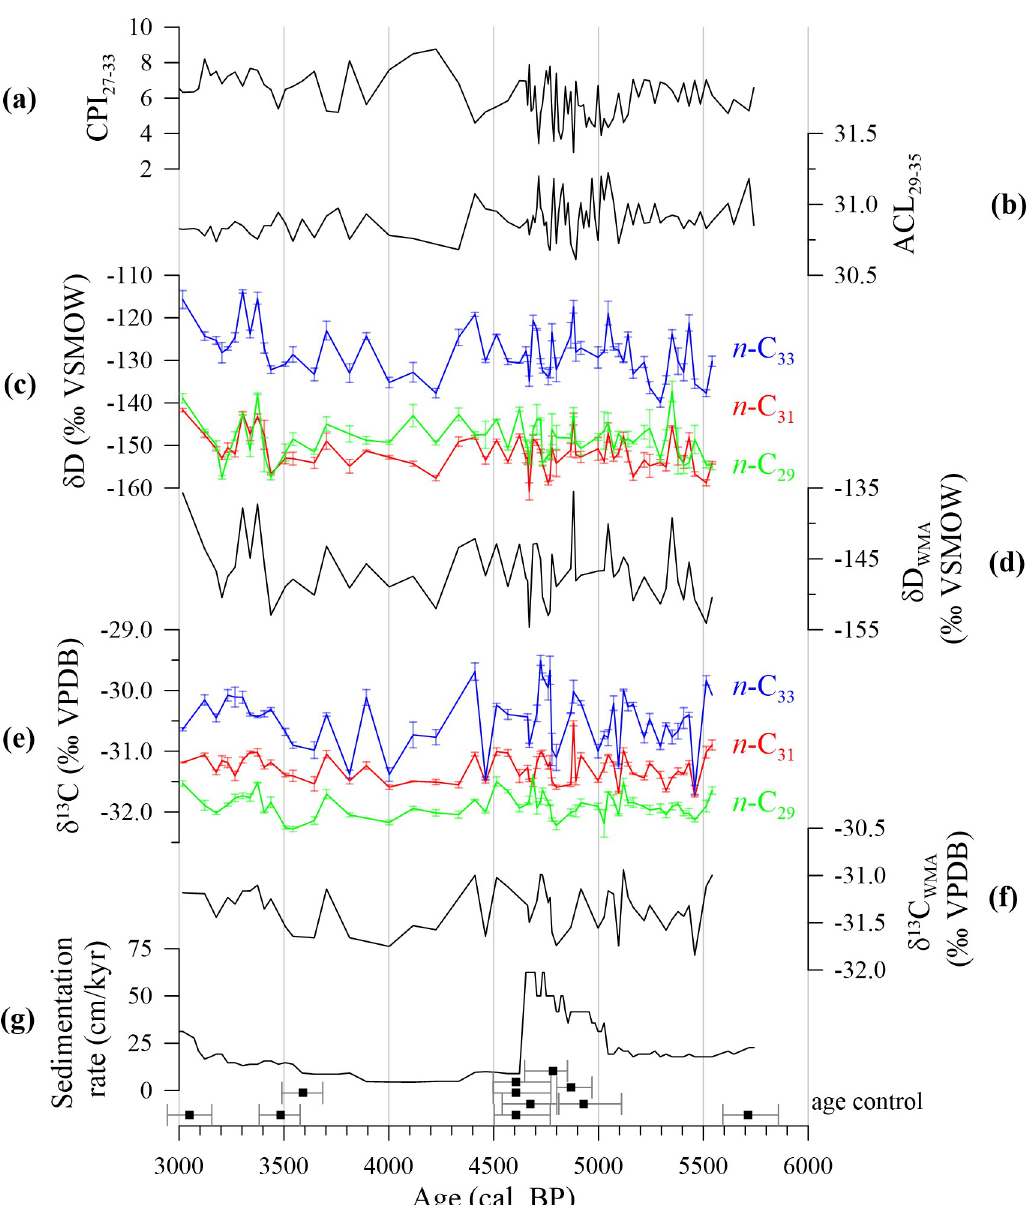
Fig 3. Molecular and isotopic n-alkane data from ODP-161-976A. a) CPI 27-33 , b) ACL 29-35 , c) hydrogen isotopic data of individual n-alkane homologues δ D C33 (blue), δ D C31 (red), and δ D C29 (green), d) weighted-mean average of all individual hydrogen isotopic records ( δ D WMA ), e) carbon isotopic data of individual n-alkane homologues δ 13 C C33 (blue), δ 13 C C31 (red), and δ 13 C C29 (green), f) weighted-mean average of all individual carbon isotopic records ( δ 13 C WMA ), and g) sedimentation rate. Black squares show calibrated AMS 14 C dates and their according uncertainties.